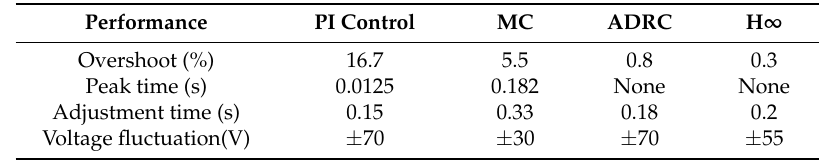
Table 2. Performance indexes of DC voltage for the converter.